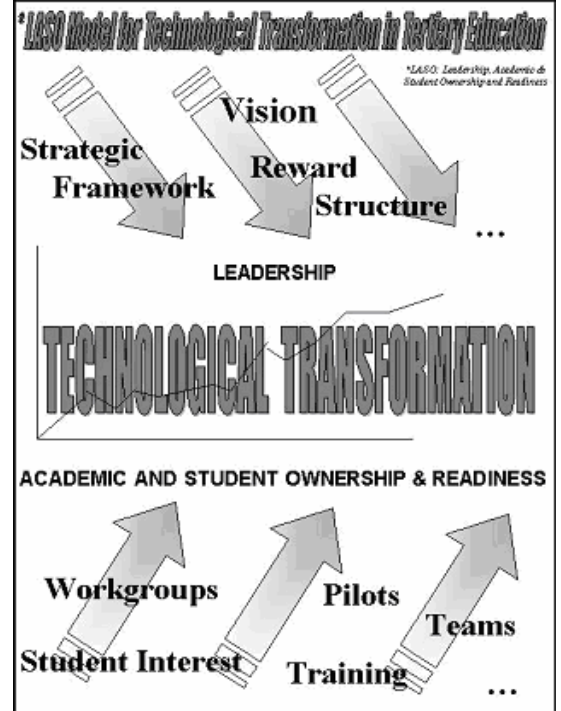
Figure 1. The Leadership, Academic and Student Ownership and Readiness (LASO) Model for Technological Transformation in Tertiary